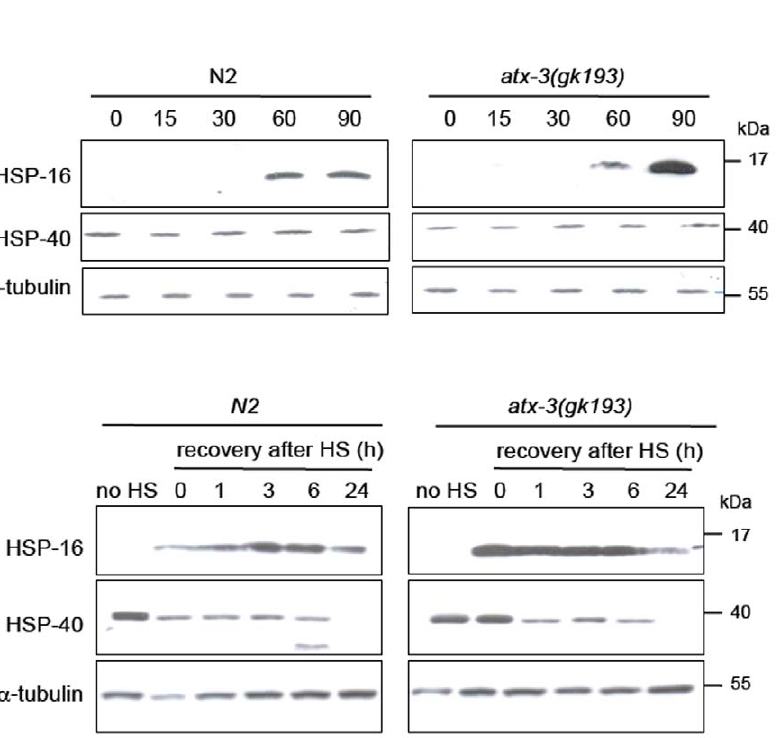
Figure 5. Atx-3 knockout animals display significant changes in the levels of molecular chaperones when grown at 25 6 C. ( A ) Western blot analysis of constitutive (HSP-4) and inducible chaperones (HSP-16 family) in wild type and atx-3 animals during the timecourse of a heat shock. HSP-40 is expressed at all timepoints while HPS-16 is only detected 60 minutes after the beginning of the heat shock. Mutants have higher levels of HSP-16 from 60–90 minutes after the beginning of the stimulus. ( C ) Atx-3 mutants have the HSP-16 family up-regulated during the timecourse of the recovery. Only at 24 h, the HSP-16 levels return back to wild type levels.